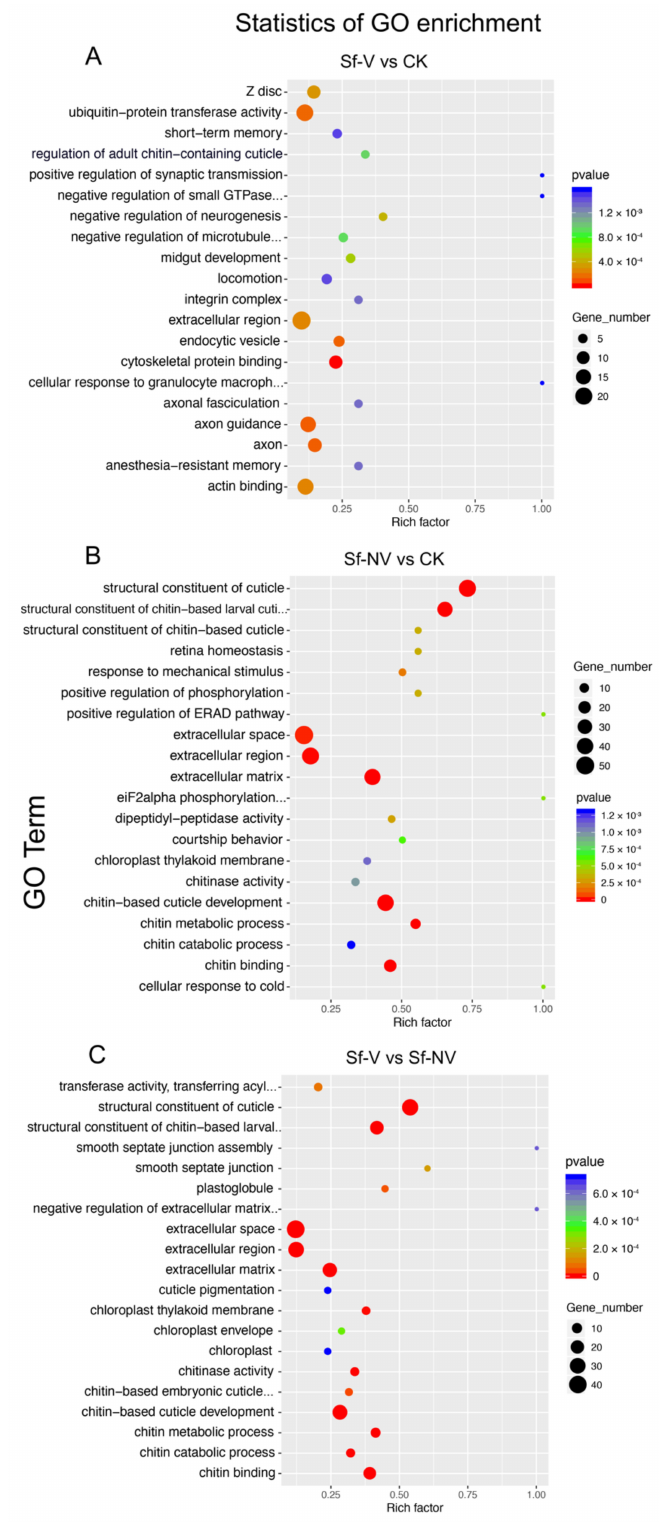
Figure 3. GO enrichment of differentially expressed genes. The enrichment factor was calculated by the numbers of DEGs in a term/the numbers of genes in the term, which reflects the degree of enrichment: Sf–V, S. furcifera females acquired SRBSDV; Sf–NV, S. furcifera females failed to acquire SRBSDV; CK, S. furcifera females exposed to healthy rice